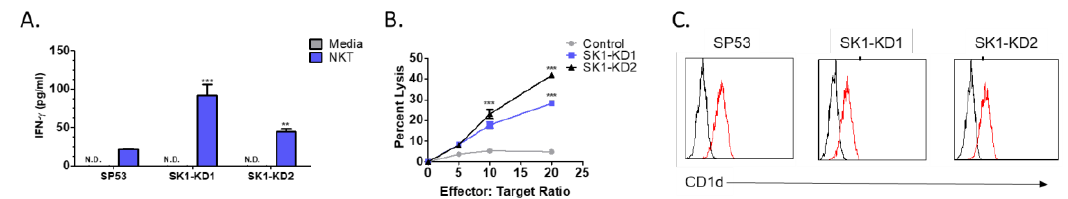
Figure 4. Knockdown of sphingosine kinase restores NKT cell responses to MCL. ( A ) Human NKT cells were co-cultured with SP53 and SK1-KD cells and NKT cell activation, as determined by IFN-γ production, was measured by ELISA. ( B ) NKT cell specific lysis of SP53, SK1-KD1, and SK1-KD2 was assessed by standard 51 Cr-release assay. ( C ) CD1d expression on SP53, SK1-KD1, and SK1-KD2 cell lines was determined by flow cytometry. Data was analyzed by one-way ANOVA. ** p < 0.001; *** p < 0.0001.